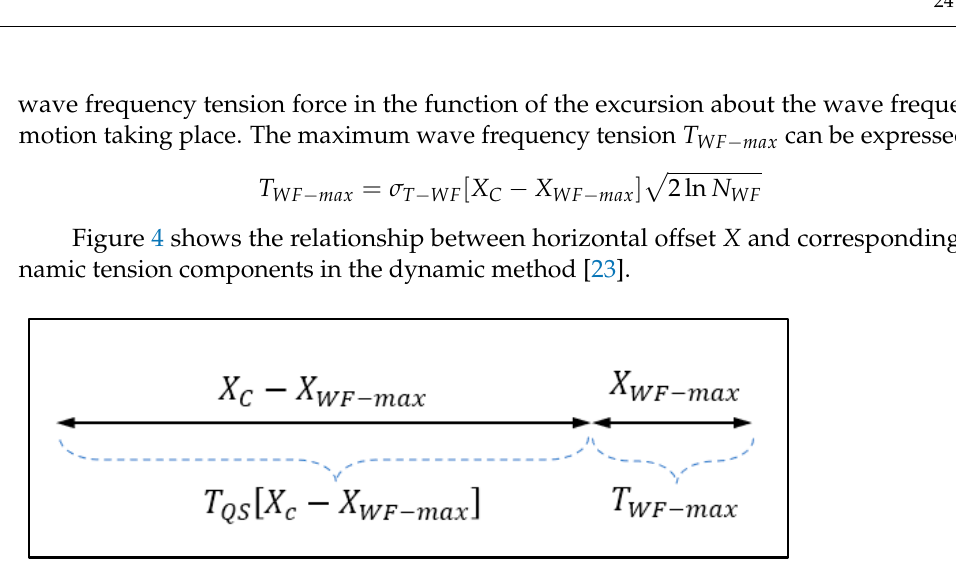
Figure 4. Relationship between horizontal distance X and the corresponding dynamic tension components in dynamic analysis.